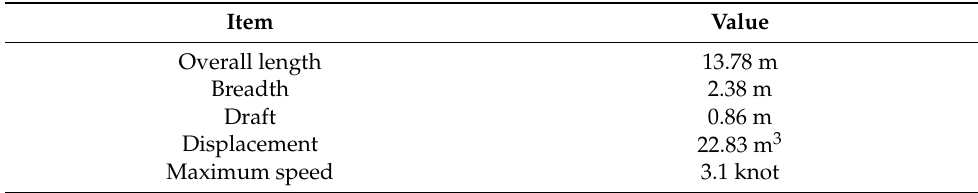
Table 2. Main particulars of training ship model Blue